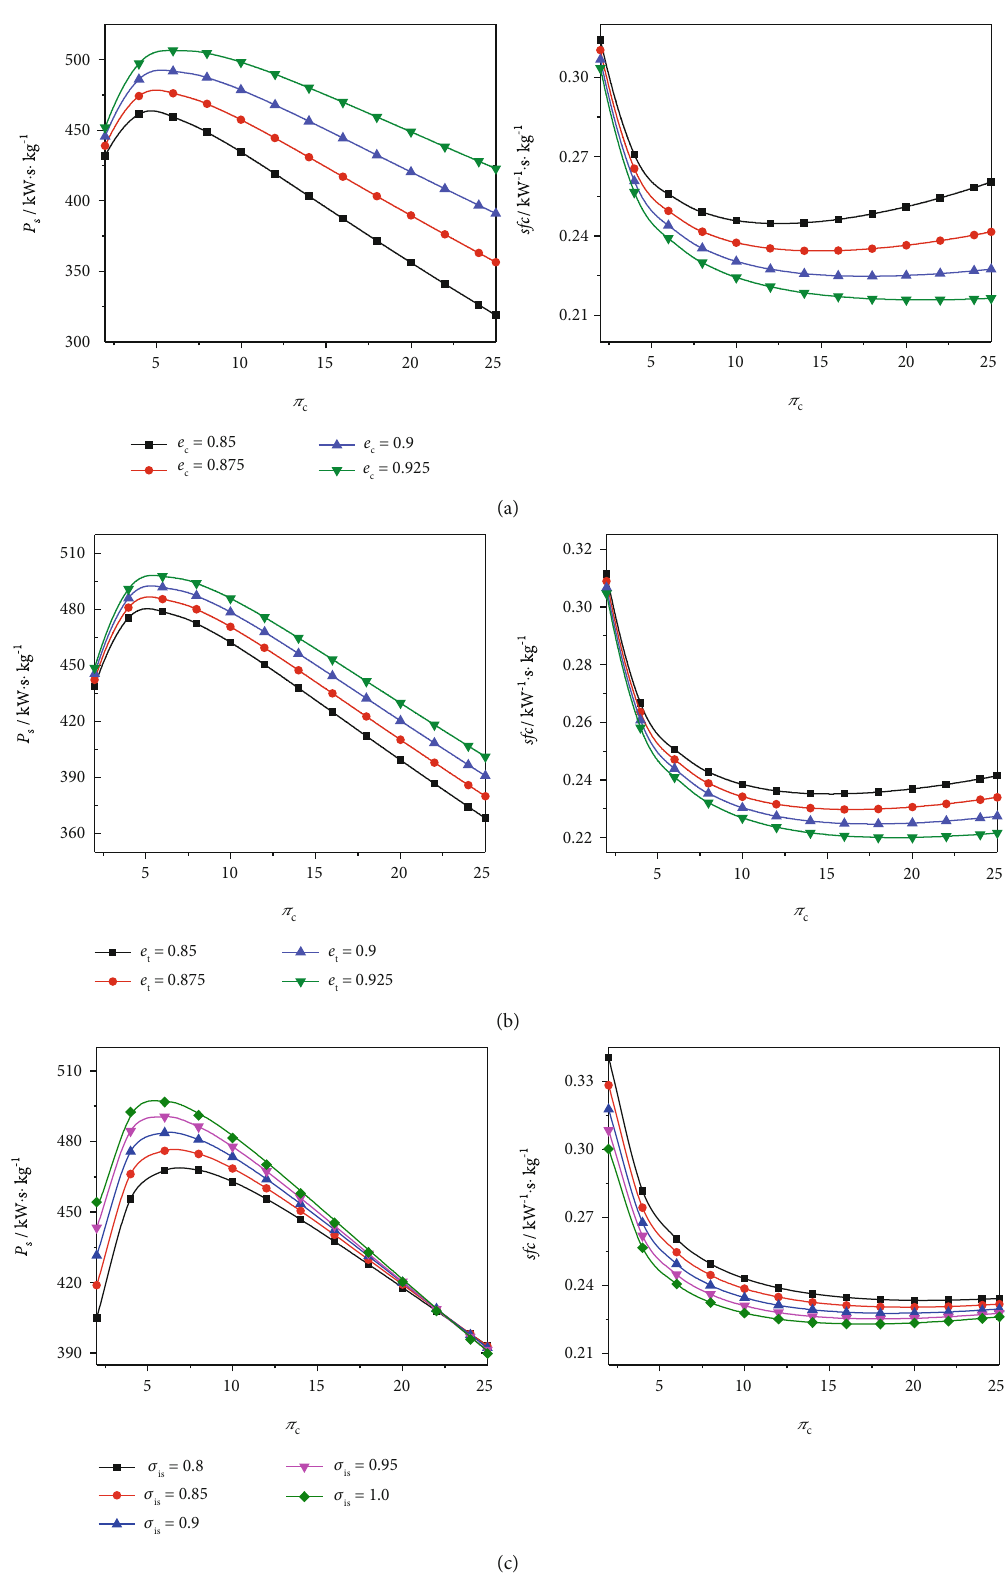
ffi ciency e c , (b) turbine polytropic e t , and (c) total